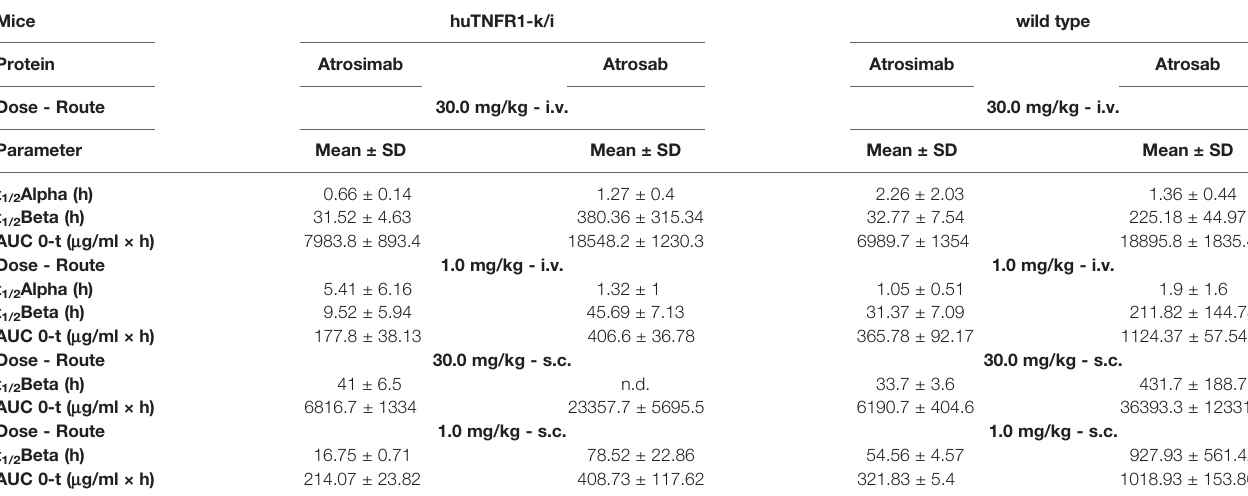
TABLE 1 | Pharmacokinetic analysis of Atrosimab and Atrosab in huTNFR1-k/i and wildtype mice.